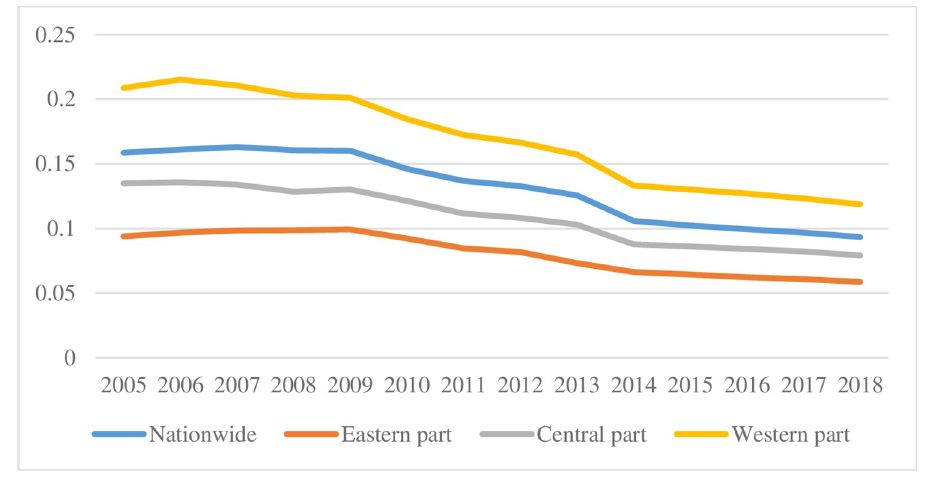
Fig 2. Urban-Rural Thiel index by region.